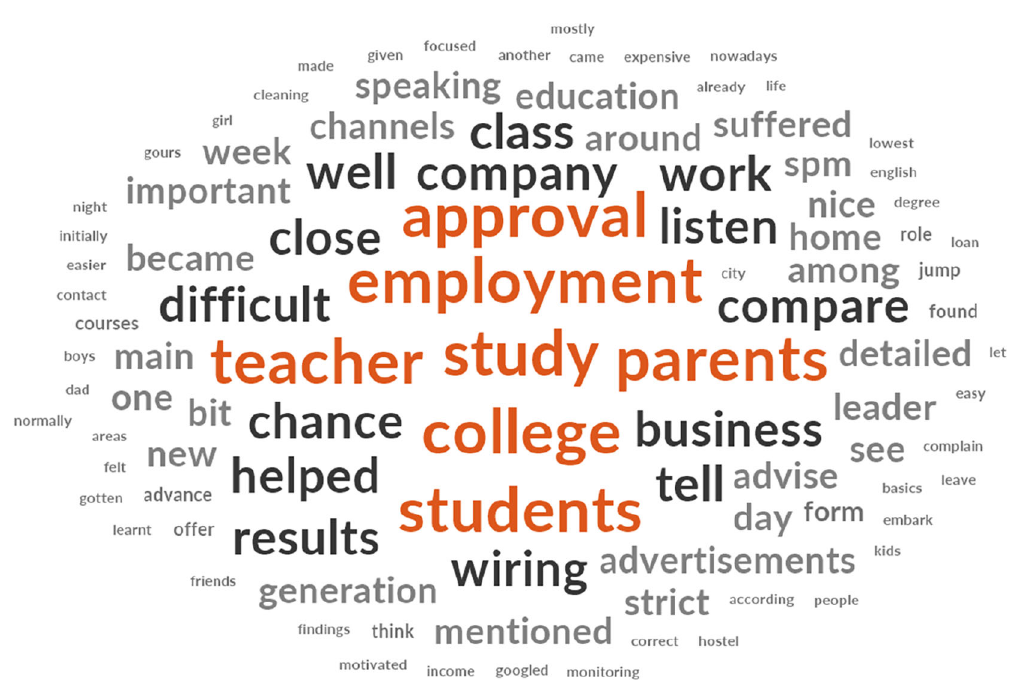
Figure 2. Word cloud diagram illustrating the key challenges faced by policymakers, training providers, and trainees.